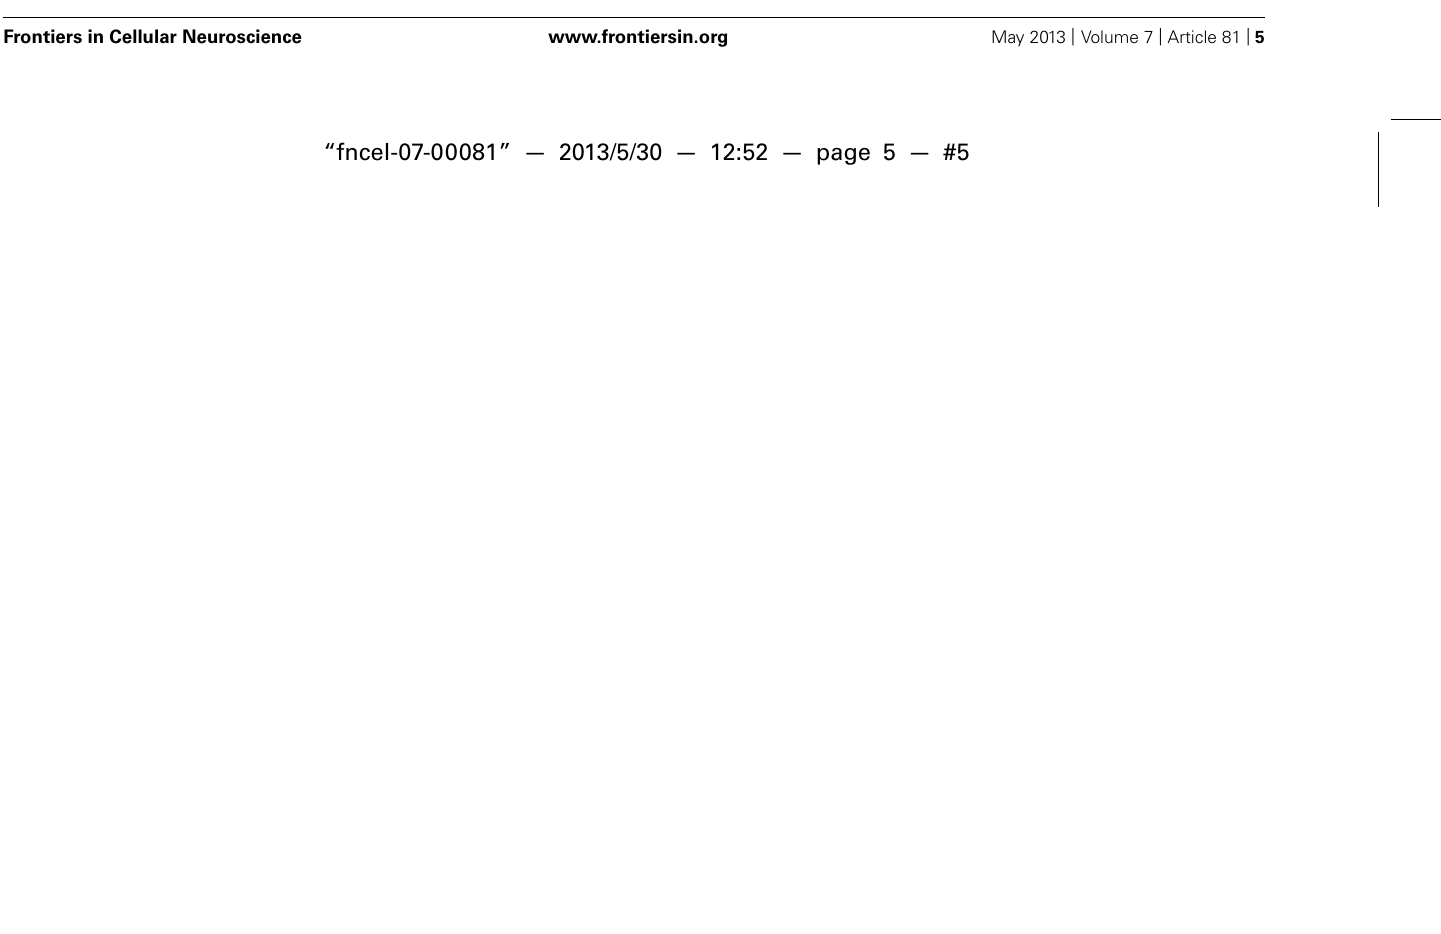
FIGURE 3 | Facilitation of monomeric and oligomeric α -syn accumulation and caspase activation by LPO. 3D5/DAT cells with 8 days of RA-elicited differentiation andTet-Off induced α -syn expression were exposed to AA for 12, 24, 36, 48, and 60 h (regarded as AA-12h, AA-24h, AA-36h, AA-48h, and AA-60h), treated with AA plusTX or AA plusTC in for 60 h (TX/AA-60h and TC/AA-60h) or without any treatment for 0 or 60 h (Con-0h, Con 60h). Cells harvested from each set of culture were split into two and used for western blotting and LPO assay. Sibling cultures of con-60h, AA-60h,TX/AA-60h, and TC/AA-60h were subjected to Calcein assay. (A) Western blotting of cell lysates with antibodies to α -syn, active caspase 3 and GAPDH. (B–D) Bar graphs represent data obtained from quantitation of immunoreactivities displayed in (A) and western blot from two additional experiments.The levels of immunoreactivity detected in controls (Con-0h) are regarded as 100%. Our